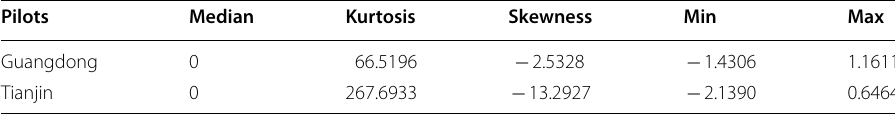
Table 1 Overall estimates of logreturns for energy-switching prices Pilots